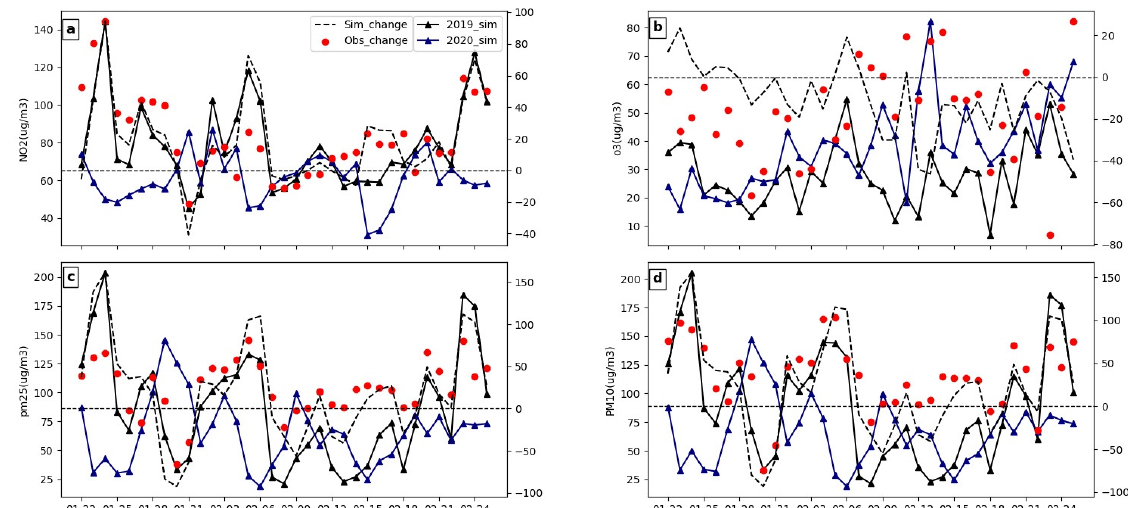
Figure 6. Time series of daily mean near-surface NO 2 , O 3 , PM 2.5 , and PM 10 concentrations ( µ g/m 3 ) simulated during the NP (black dashed line with triangles, 2019_sim) and LP (blue dashed line with triangles, 2020_sim), Differences in observed NO 2 , O 3 , PM 2.5 , and PM 10 concentrations ( µ g/m 3 ) between the NP and LP (red dots, Obs_change), Differences in model simulations between the NP and LP for NO 2 , O 3 , PM 2.5 , and PM 10 concentrations ( µ g/m 3 ) (black dashed line, Sim_change). ( a ) represents NO 2 , ( b ) represents O 3 , ( c ) represents PM 2.5 , ( d ) represents PM 10 . Table 6. Statistics comparing the differences in observed and modeled daily mean concentrations ( µ g/m 3 ) of NO 2 , O 3 , PM 2.5 and PM 10 during the NP and LP. AVGM